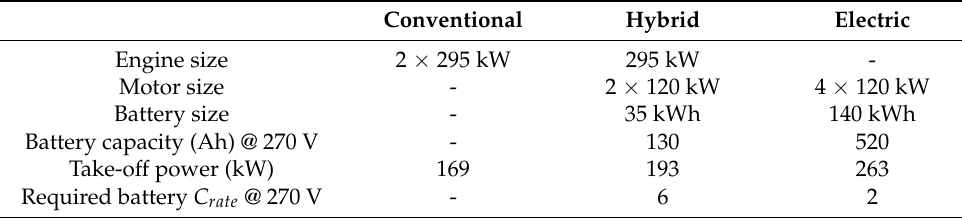
Table 3. Specification of the 2035 powertrains.